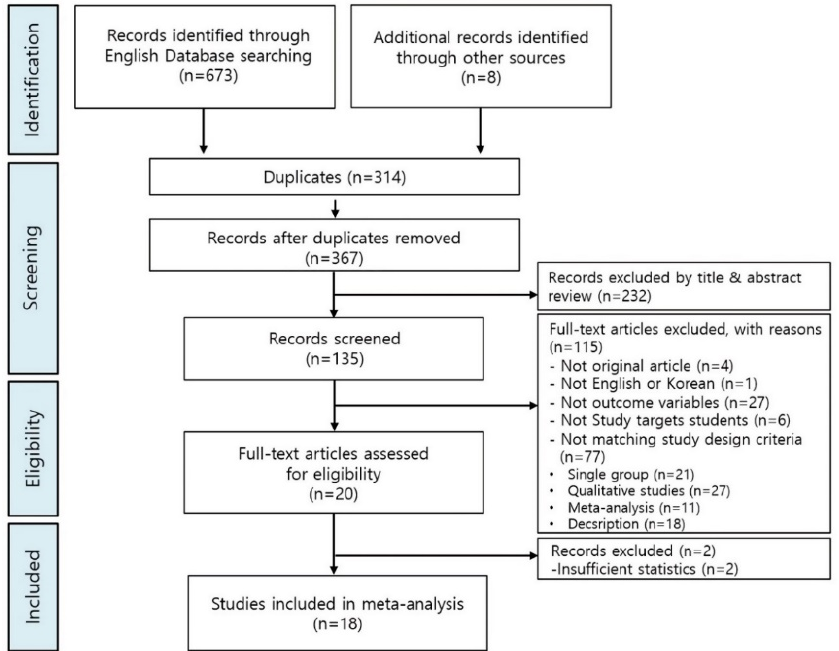
Figure 1. Flowchart of study selection.